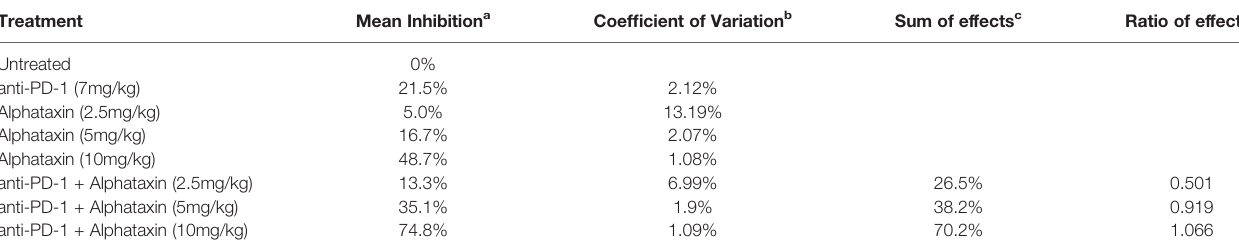
TABLE 1 | Additive vs Synergistic Effects on Tumor Growth by Anti-PD-1 and Alphataxin.